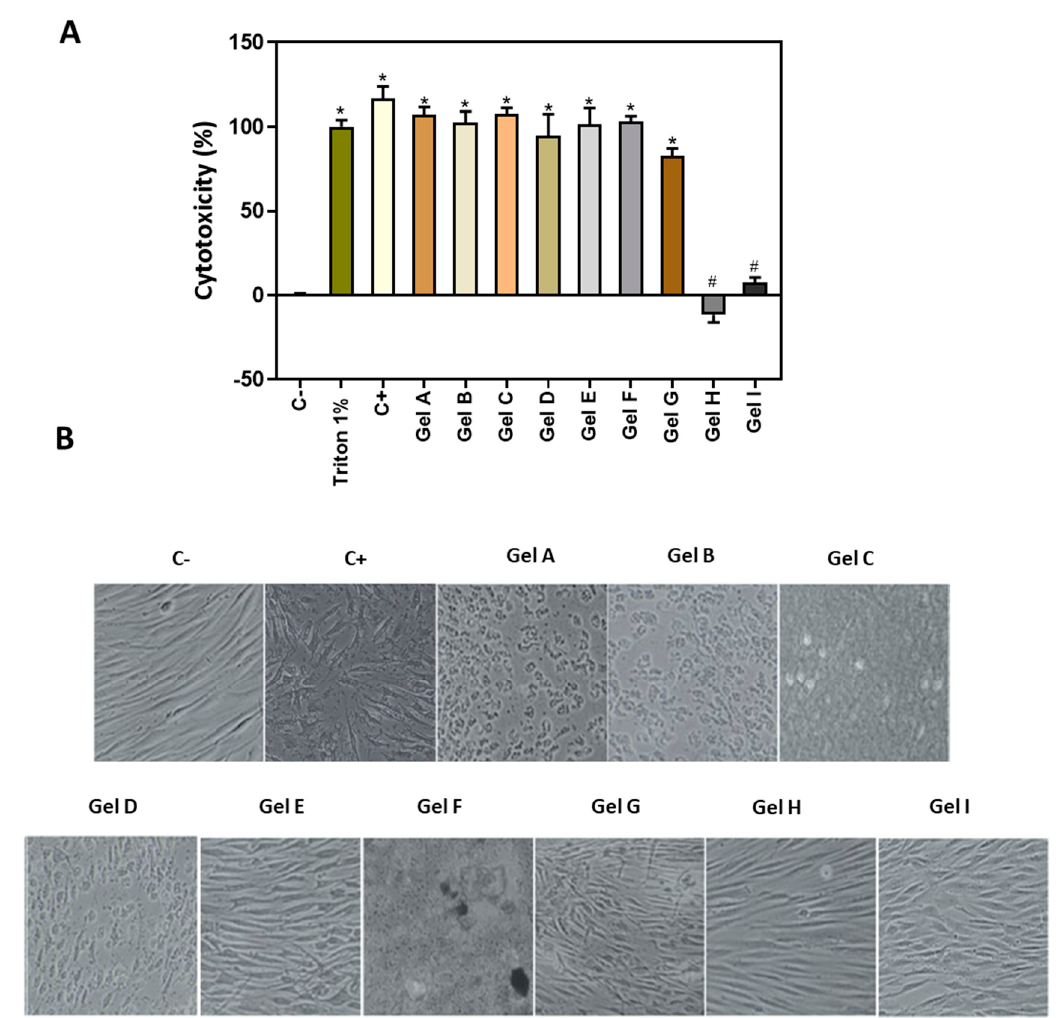
Figure 4. In vitro study 2D cell culture model. ( A ) LDH activity, an indicator of cytotoxicity, measured in culture media after the application of treatments and healing for 48 h. Negative control (C − ) (0% toxicity) was obtained from culture media of cells seeded on plastic without treatment. To obtain 100% toxicity, 1% triton X-100 was used. Positive control (C+) was obtained from cells seeded on plastic and treated with CHX at 0.2%. See Table 1 for the identification of gels used in the study. ( B ) Images of cell morphology at 24 h of treatment with the different gels, images were taken at a magnification of 100×. Values represent the mean ± SEM ( n = 6). Results were statistically compared by ANOVA and LSD as a post hoc: * p < 0.05 treatment vs. negative control. # p < 0.05 treatment vs. positive control.